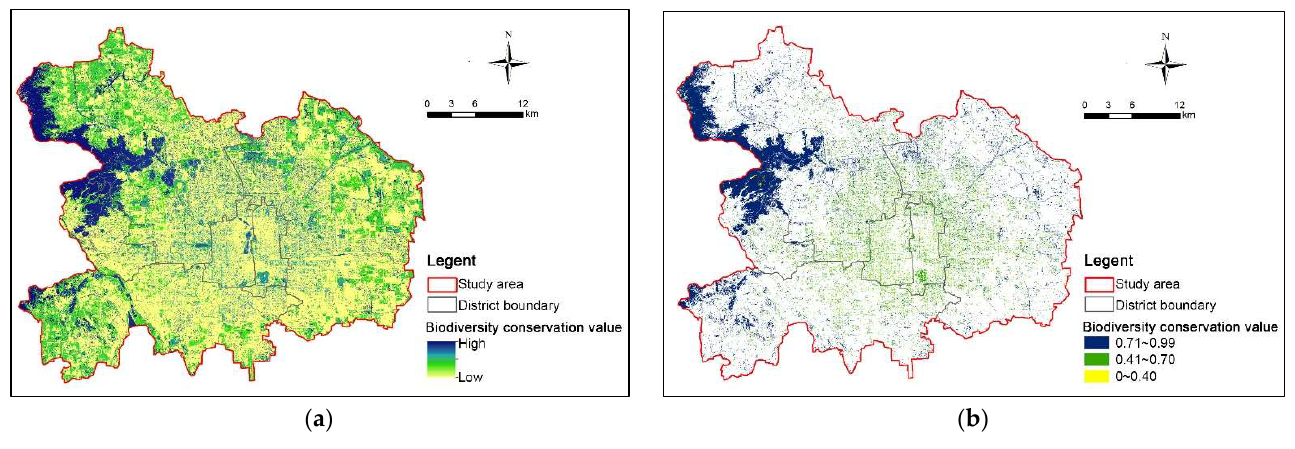
Figure 4. ( a ) Spatial distribution of overall biodiversity conservation services in the study area; ( b ) spatial distribution of urban forest biodiversity conservation services. ( b ) spatial distribution of urban forest biodiversity conservation services. Table 5. The distribution of the levels of biodiversity conservation services. Table 5. The distribution of the levels of biodiversity conservation